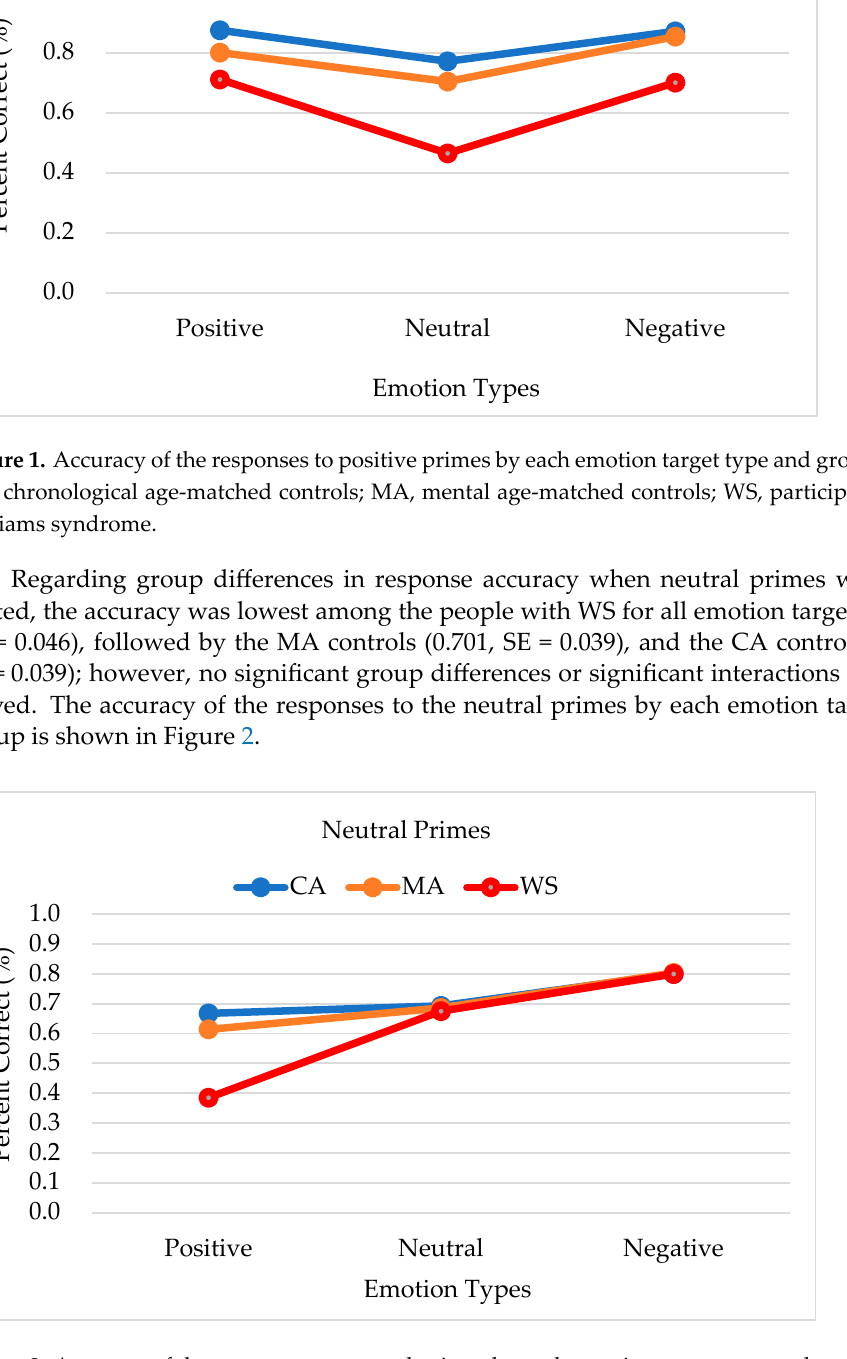
Figure 2. Accuracy of the responses to neutral primes by each emotion target type and group. Note. CA, chronological age-matched controls; MA, mental age-matched controls; WS, participants with Williams syndrome.